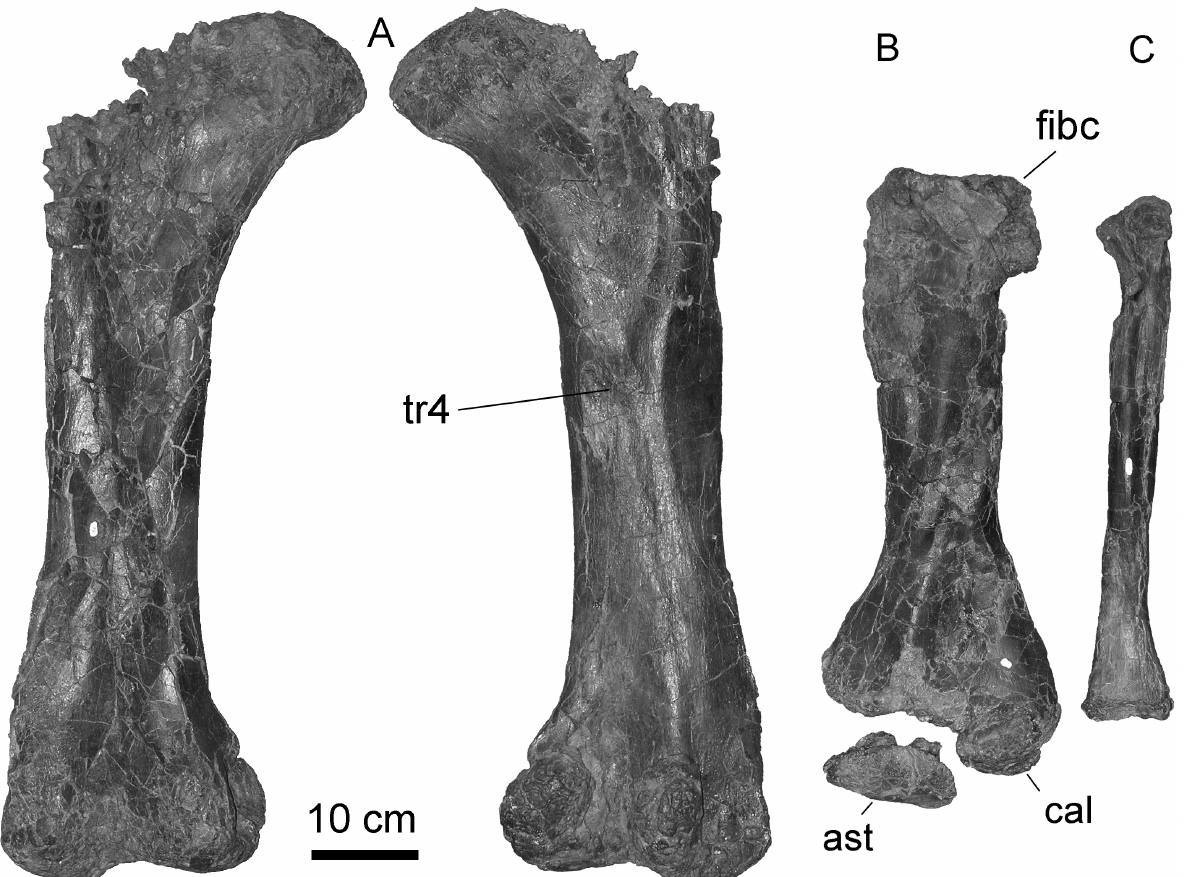
Figure 21. A, right femur in extensor (anterior) and flexor (posterior) views; B, right tibia in flexor (posterior) view. C, right fibula in flexor (posterior) view. Vagaceratops irvinensis , CMN 41357.